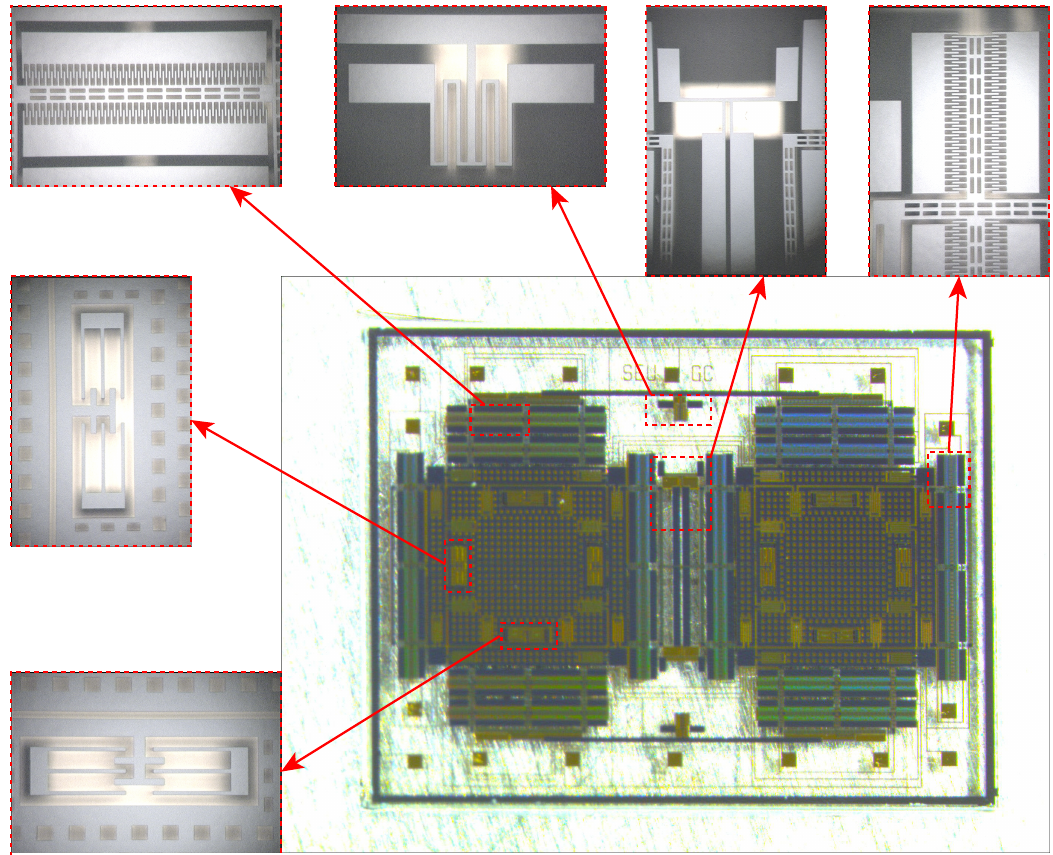
Figure 16. The SEM photos of the